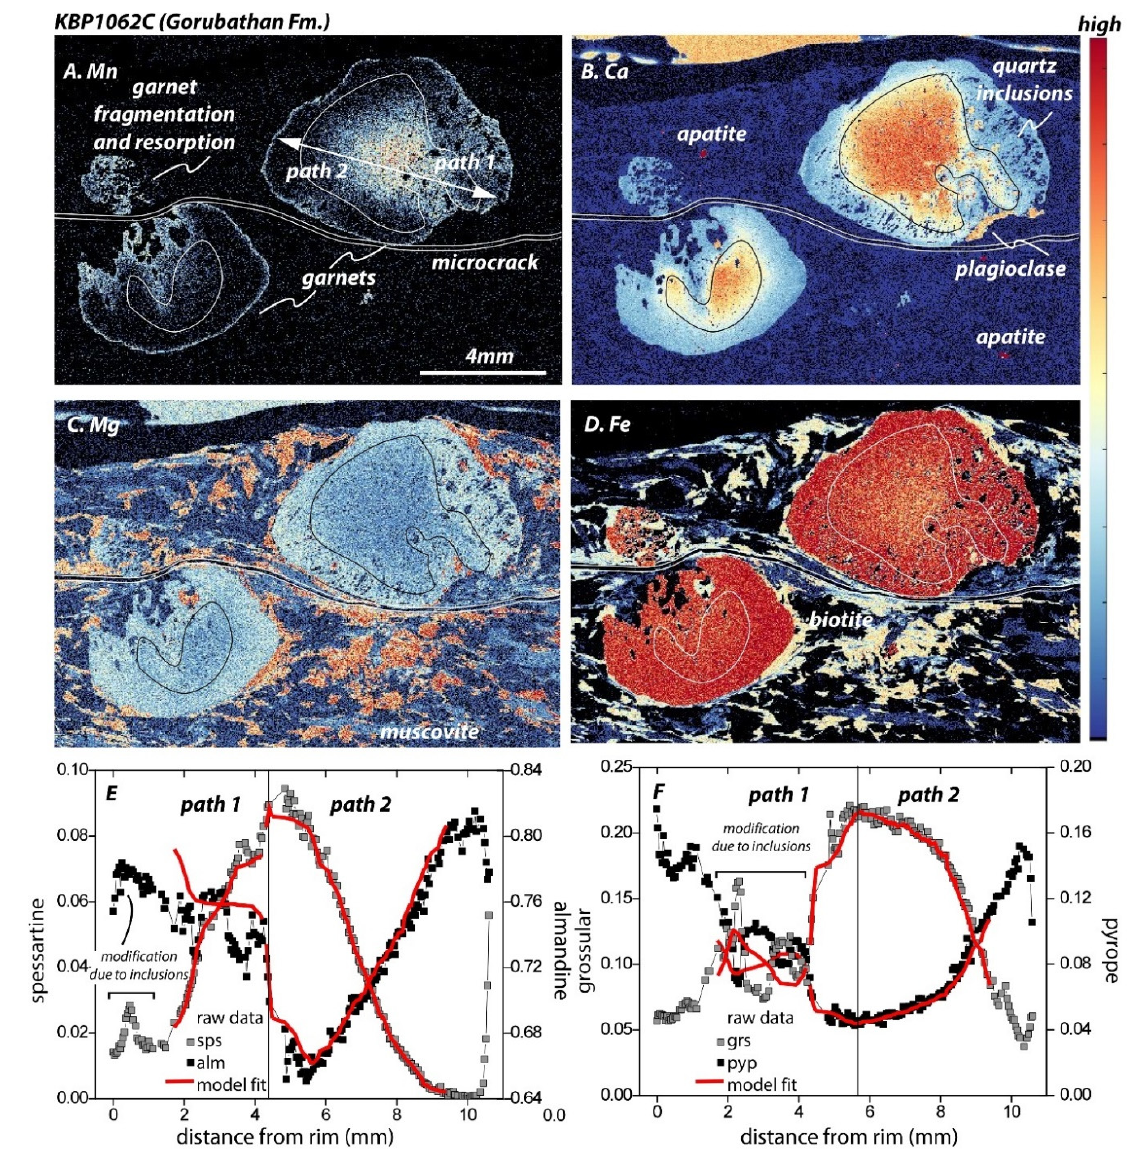
Figure 3. X-ray element maps of sample KBP1062C (Gorubathan Fm.) in ( A ) Mn, ( B ) Ca, ( C ) Mg, and ( D ) Fe. Garnet compositions in spessartine (sps) and almandine (alm) (panel E ) and grossular (grs) and pyrope (pyp) (panel F ) were taken across the rim to rim transect in panel ( A ). The red lines in panels ( E , F ) show the prediction of two high-resolution P-T paths generated for this sample. We also indicate the presence of a large microcrack that cuts a garnet in the left side of the X-ray element maps and highlight the presence of quartz inclusions that appear to have modified compositions used to generate path 1 for this garnet.